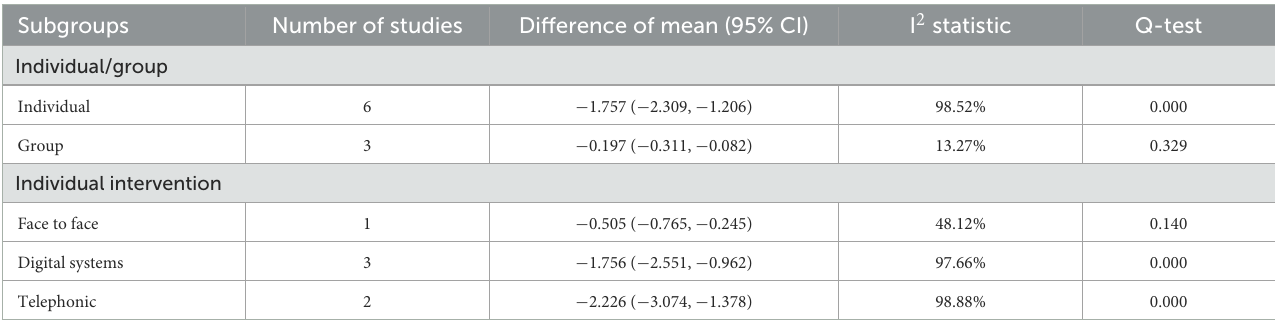
TABLE 3 Effect of the type of intervention on affective